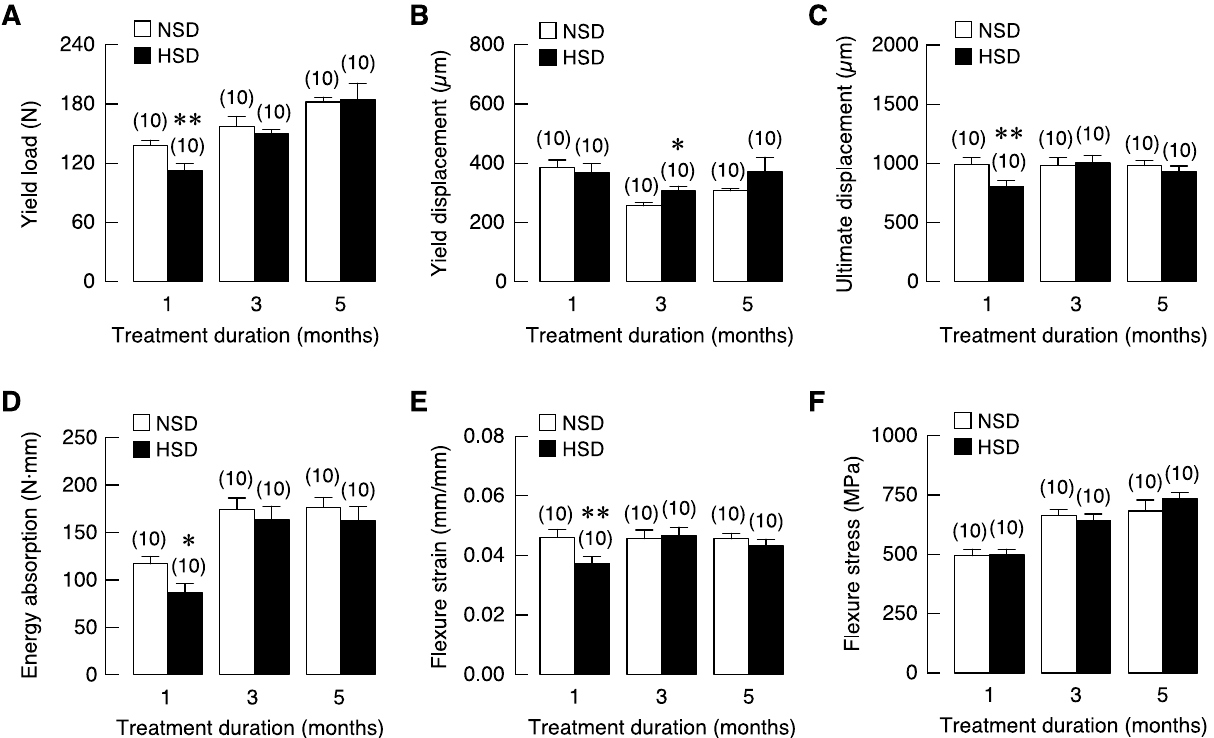
Figure 9. Mechanical property analysis of femurs of NSD and HSD. ( A ) Yield load, ( B ) yield displacement, ( C ) ultimate displacement, ( D ) energy absorption, ( E ) flexure strain and ( F ) flexure stress. Numbers in parentheses are numbers of animals in each group. * P < 0.05, ** P < 0.01 compared to period-matched